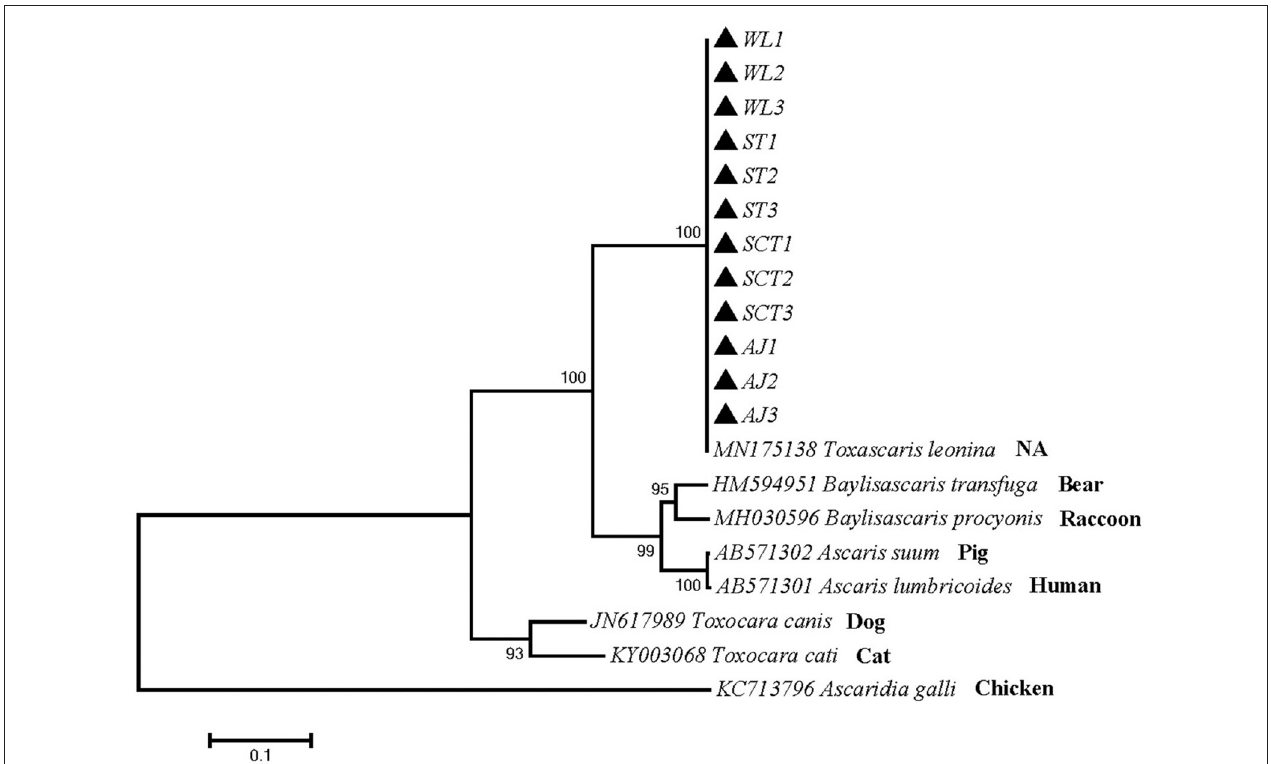
FIGURE 2 | Neighbor-Joining estimates of the phylogenetic relationships of ascarids based on ITS gene computed in MEGA version 7.0 under the Kimura 2-parameter model; The confidence levels in each node were assessed with the bootstrap method (1,000 pseudoreplicates) and bootstrap values > 50; The genotypes identified in this study are indicated by filled